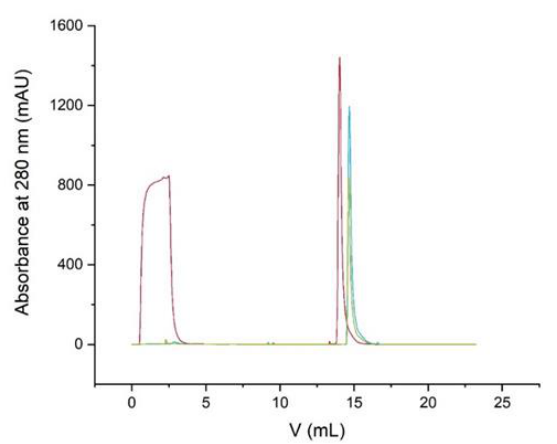
Figure 13. The purity of the isolated human IgG was examined by two reinjections of the first pas- sage (UV absorbance detection, 280 nm). The area of the void peak (retention time around 2.5 min) in relation to the product peak (retention time around 15 min) revealed a content of 20.6% of IgG (raw human plasma), 96.1% in the first isolation step, and 98.7% after a polishing step performed by reinjection.